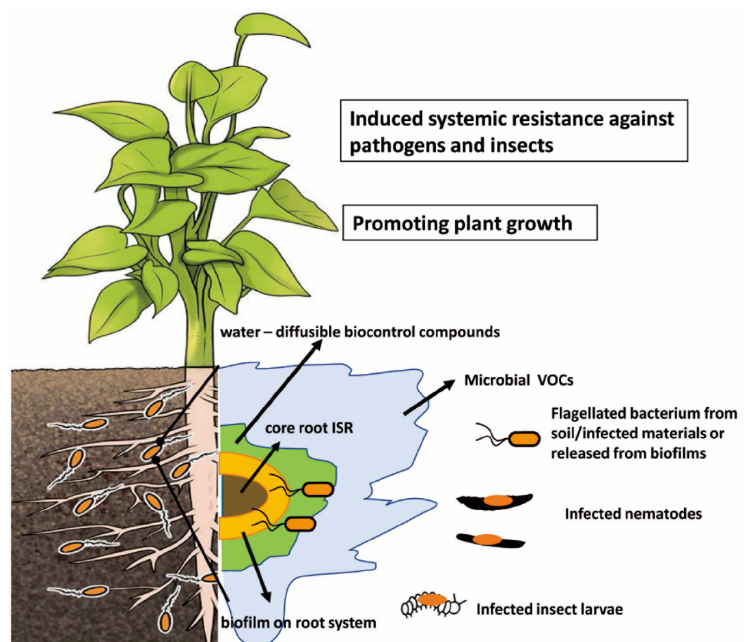
Figure 1. The multiple impacts of biocontrol-active bacteria in the rhizosphere and extending out into bulk soil. Biocontrol microbes are accepted as plant root colonists while exerting antagonism against plant pests through several layers of control in the rhizosphere space. Defense by induced systemic resistance (ISR) may be triggered by metabolites from the biocontrol root colonists. The patchy biofilms on the root surface provide protective barriers. Aqueous diffusion in soil pore waters distributes antagonistic metabolites and enzymes secreted by the biocontrol colonists further into the rhizosphere and biocontrol-active volatiles will diffuse to bulk soil, even to the airspace. These mechanisms boost the survival of the biocontrol bacteria, with their protection within biofilms and spread through chemotaxis and swarming at the rhizoplane. Movement of infected nematodes and insect larvae transport inocula away from the root, and these structures act as hot spots for production of antagonistic products from the biocontrol